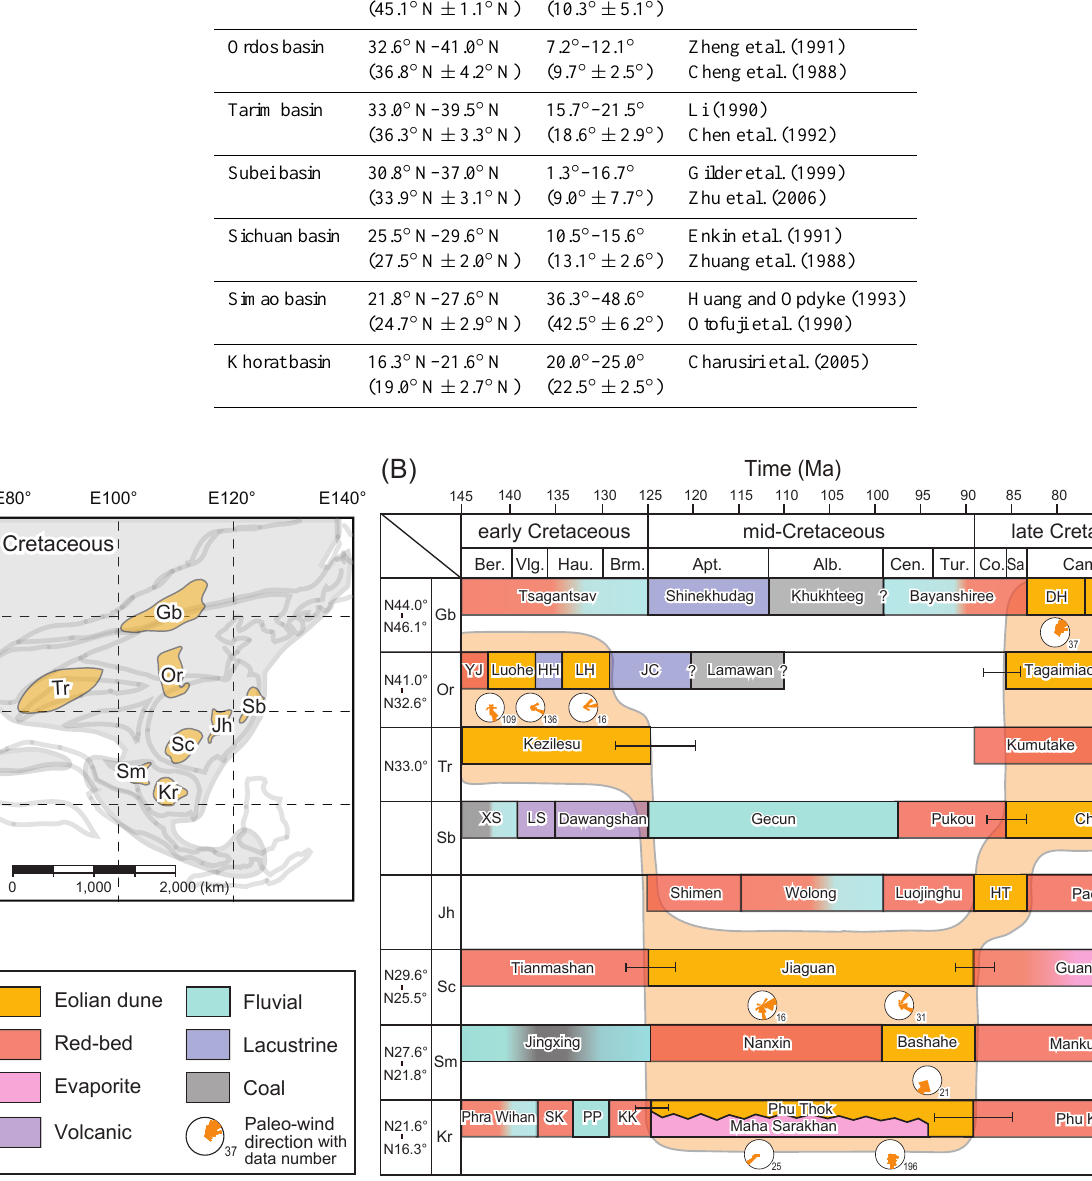
Fig. 1. (A) Paleogeographic map of the Asian continent during the Cretaceous, showing the locations of sedimentary basins cited in this study (modified after Eldridge et al., 2000; Table 1). Abbreviated basin names are as follows: Gb=Gobi; Or=Ordos; Tr=Tarim; Sb=Subei; Jh=Jianghan; Sc=Sichuan; Sm=Simao; Kr=Khorat. (B) Stratigraphic chart of climate-indicative sediments and rose diagrams of paleo- wind directions recorded in eolian dune deposits. The vertical axis is arranged (from north to south) based on the paleolatitudes of the studied basins, forming a latitudinal cross-section of mid- and low-latitude records. The horizontal axis represents depositional ages of the formations, estimated based on biostratigraphic and magnetostratigraphic data (see Supplement). Estimation errors are indicated as er- ror bars. Abbreviated stage names are as follows: Ber=Berriasian; Vlg=Valanginian; Hau=Hauterivian; Brm=Barremian; Apt=Aptian; Alb=Albian; Cen=Cenomanian; Tur=Turonian; Co=Coniacian; Sa=Santonian; Camp=Campanian; Maas=Maastrichtian. Abbreviated formation names are as follows: DH=Djadokhta; BG=Barungoyot; NE=Nemegt; DM=Dzunmod; YJ=Yijun; HH=Huanhe-Huachi; LH=Luohangdong; JC=Jingchuang; XS=Xihengshan; LS=Longwangshan; HT=Honghuatao; SK=Sao Khua; PP=Phu